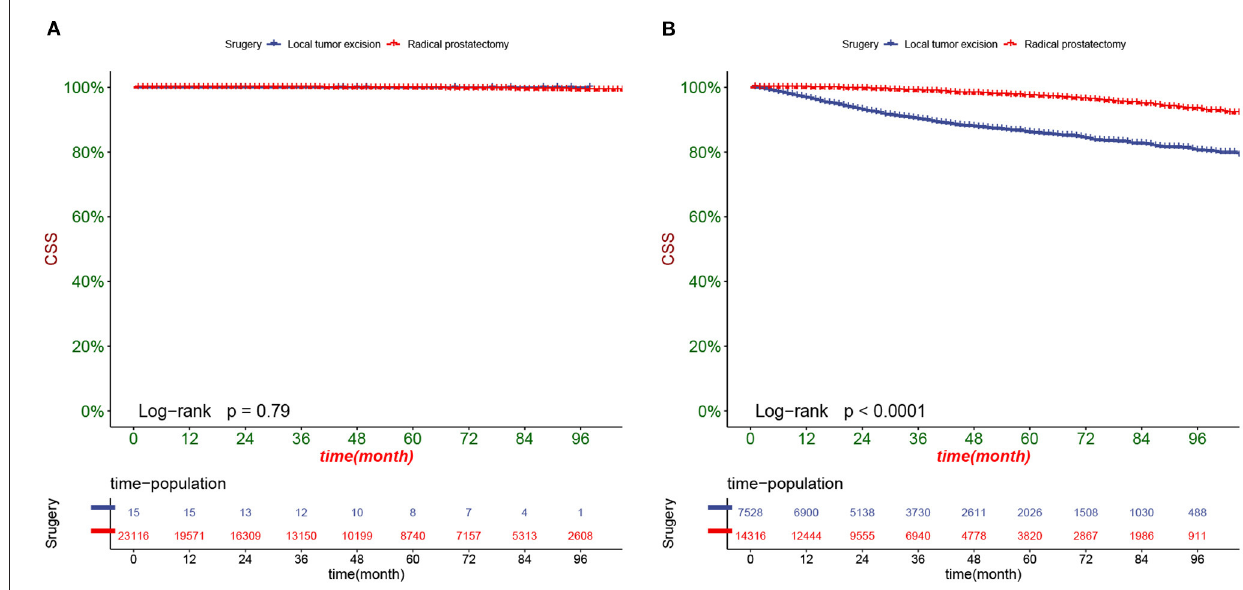
FIGURE 7 | Kaplan-Meier curves of patients with different surgery in the low-risk group (A) and high-risk group (B) .